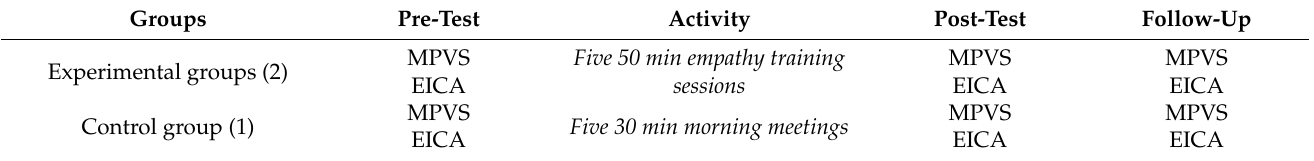
Table 1. Group and experimental design.